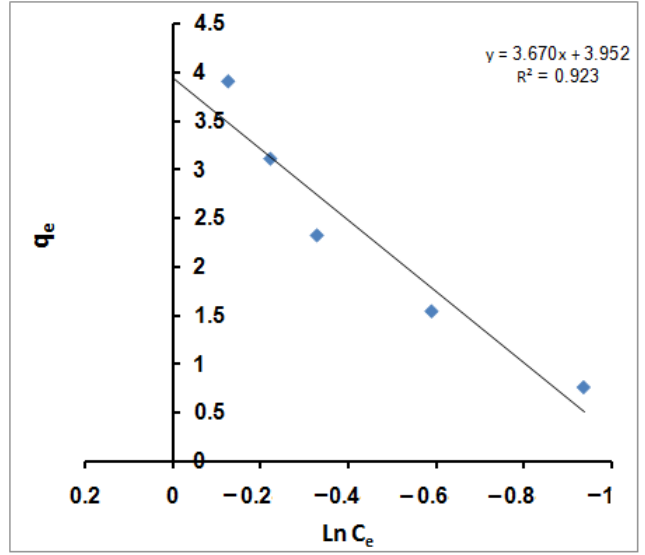
Figure 5. Temkin isotherm for MB adsorption using SPGMA.